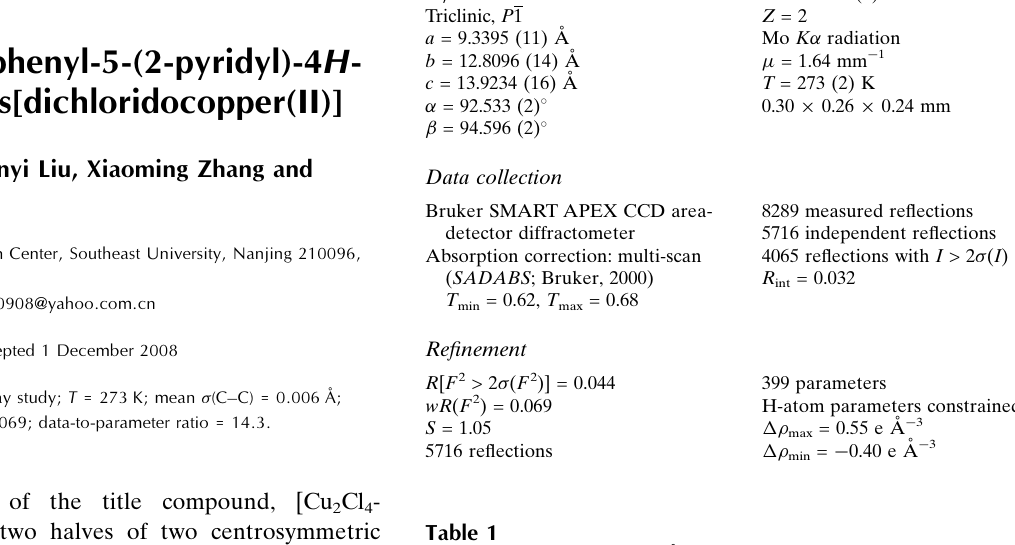
Hydrogen-bond geometry (A˚ , (cid:2)